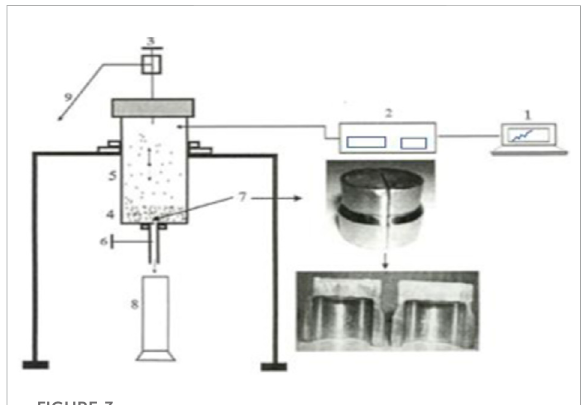
FIGURE 3 Schematic particle bridging testing experimental